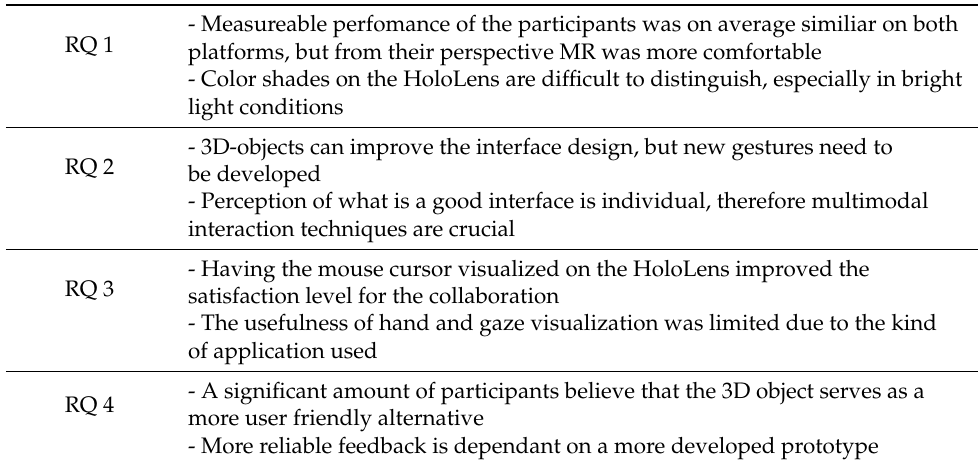
Table 1. Overview of the main findings of our